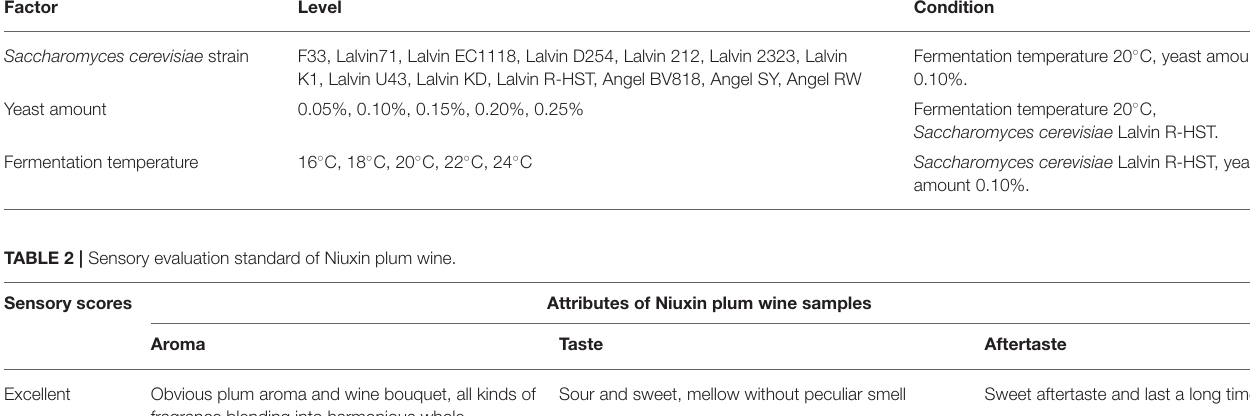
TABLE 1 | Single factor experiments for fermentation conditions of Niuxin plum wine. Factor Level